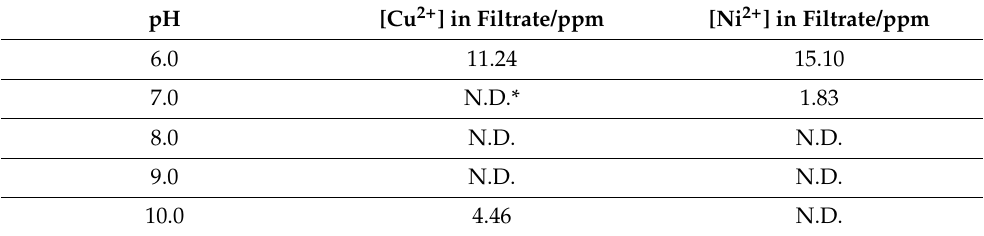
Table 1. Residual concentrations of copper and nickel ions in filtrate at different pH values.